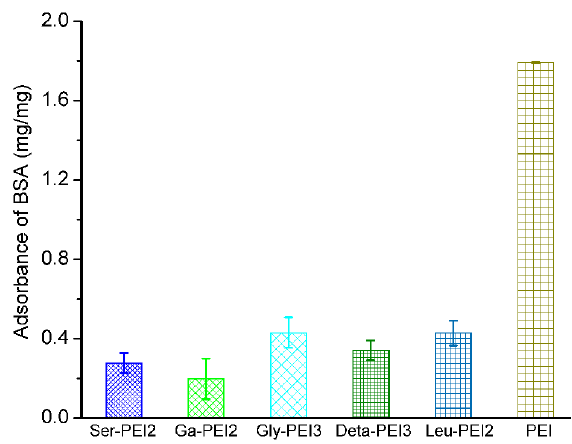
Figure 8. Comparison of protein adsorption between the polymers. 1 Milliliter of polymer solution (1 mg/mL) was added to 1 mL bovine serum albumin (BSA) solution (2 mg/mL) and co-incubated with shaking at 37 °C for 0.5 h prior to measurement. Data represent mean ± SD ( n = 3).